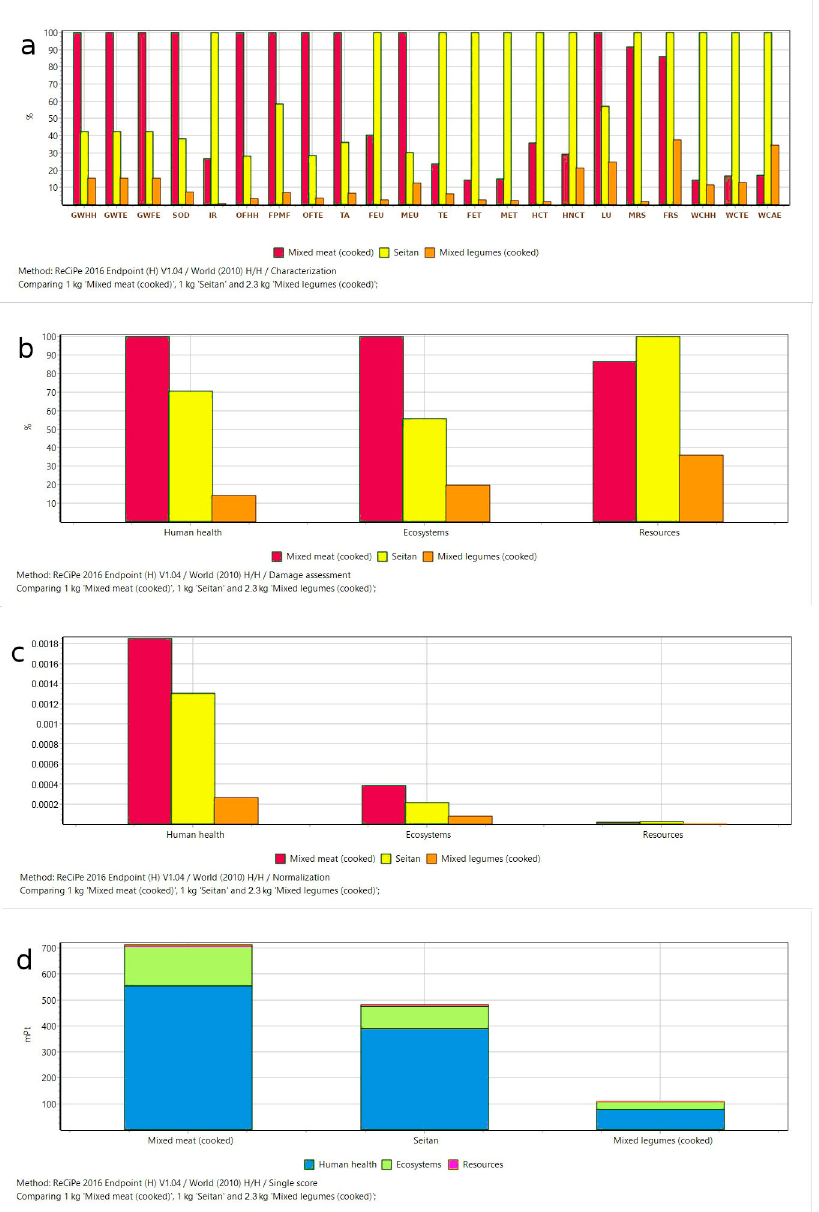
Figure A6. Comparison among Mixed Meat, Seitan and Mixed Legumes: ( a ) Characterization; ( b ) Damage Assessment; ( c ) Normalization; ( d ) Aggregated Weighted Average (Single Score). GWHH: Global warming, Human health; GWTE: Global warming, Terrestrial ecosystems; GWFE: Global warming, Freshwater ecosystems; SOD: Stratospheric ozone depletion; IR: Ionizing radiation; OFHH: Ozone formation, Human health; FPMF: Fine particulate matter formation; OFTE: Ozone formation, Terrestrial ecosystems; TA: Terrestrial acidification; FEU: Freshwater eutrophication; MEU: Marine eutrophication; TE: Terrestrial ecotoxicity; FET: Freshwater ecotoxicity; MET: Marine ecotoxicity; HCT: Human carcinogenic toxicity; HNCT: Human non-carcinogenic toxicity; LU: Land use; MRS: Mineral resource scarcity; FRS: Fossil resource scarcity; WCHH: Water consumption, Human health; WCTE: Water consumption, Terrestrial ecosystem; WCAE: Water consumption, Aquatic ecosystems.